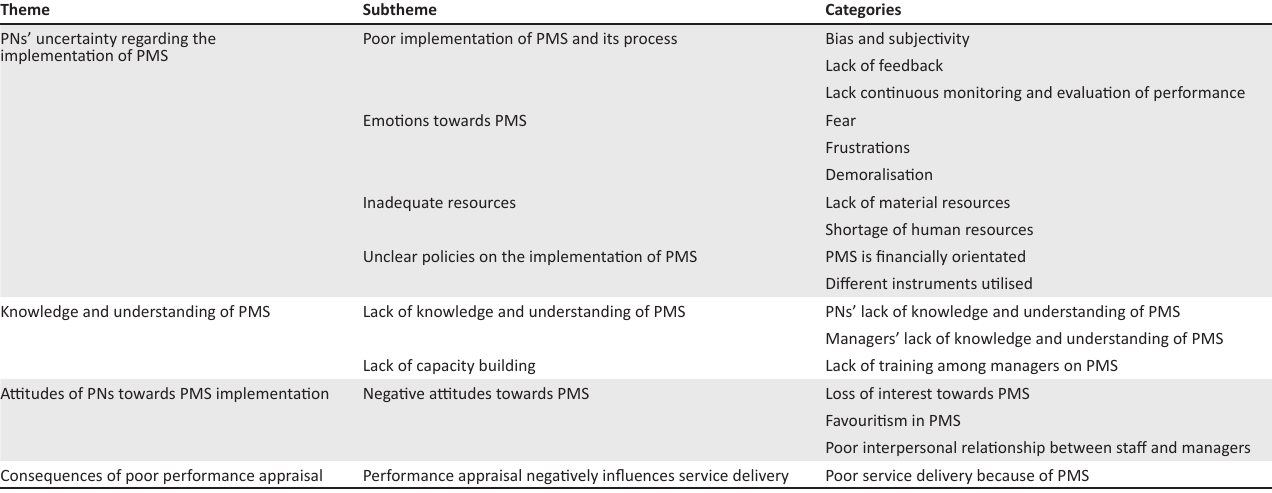
TABLE 2: Lived experiences of professional nurses regarding performance management system